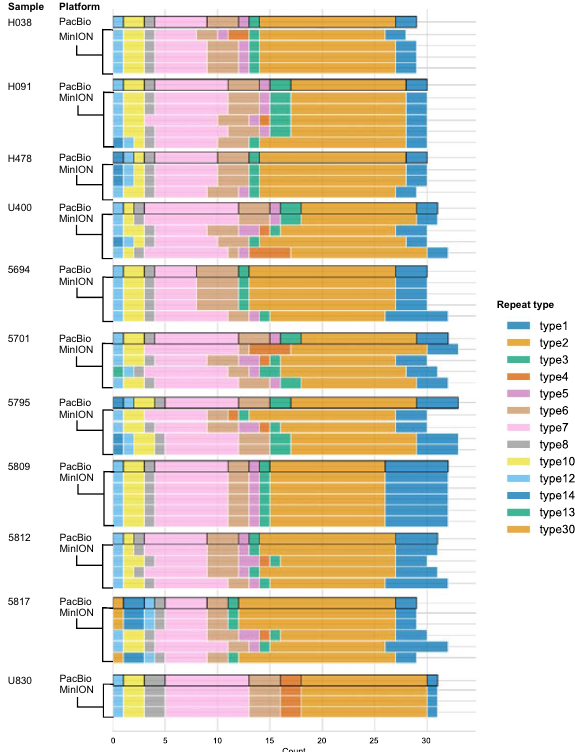
Figure 5. PacBio and MinION contig repeat type patterns for field samples. A random selection of contig repeat-type patterns from the PacBio sample set, comparing the patterns in the PacBio-derived contig with the MinION-derived contigs. For all repeat-type patterns, see Supplementary Table